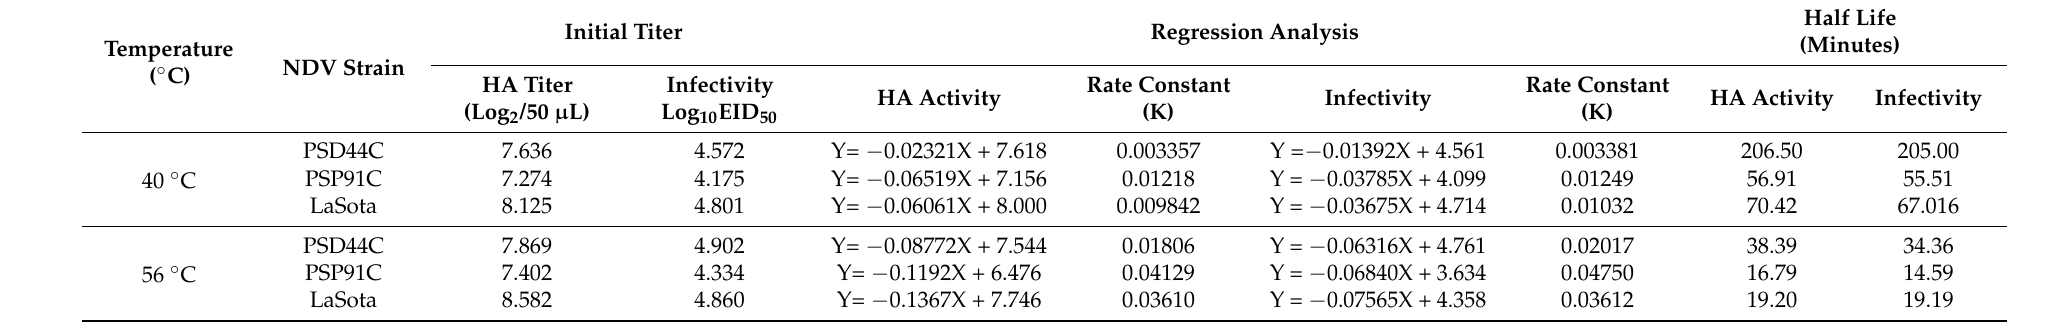
Table 2. Comparison of degradation values of PSD44C, PSP91C and LaSota exposed at 40 ◦ C and 56 ◦ C for different time